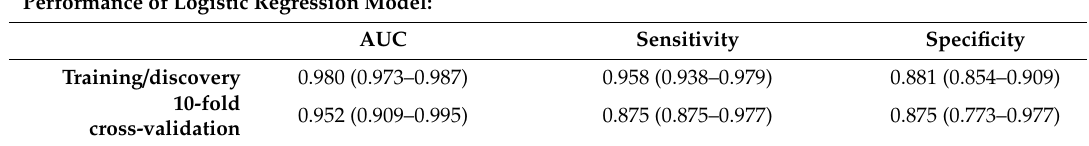
Logistic Model with Selected